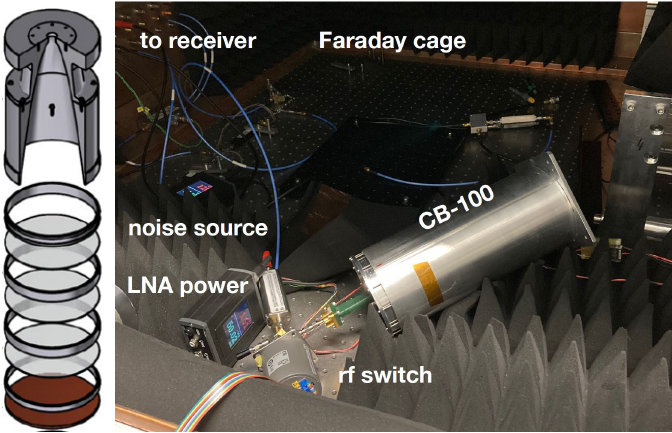
Figure 4. Left: Explosion drawing of CB100. Right: CB100 inside Faraday